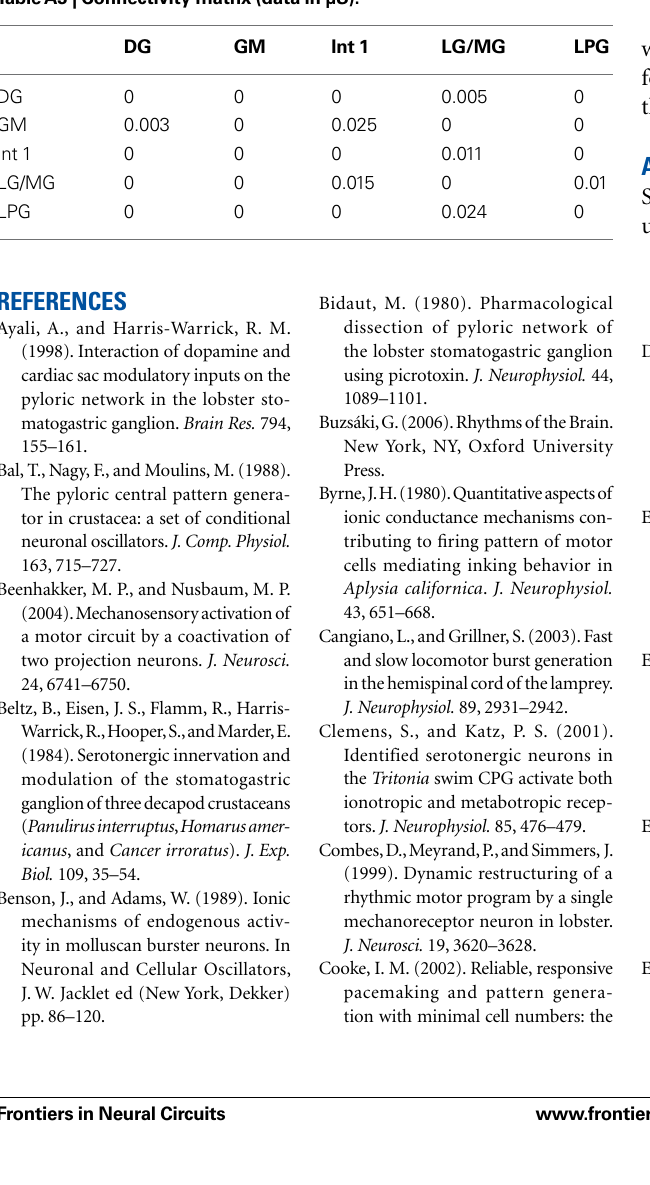
Table A3 | Connectivity matrix (data in